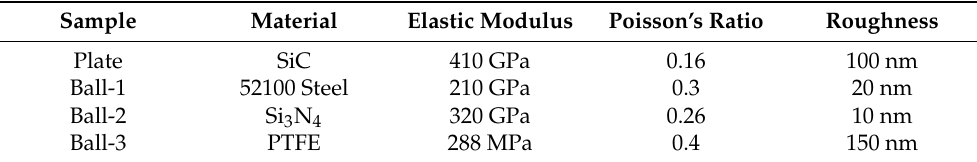
Table 2. Sample properties.